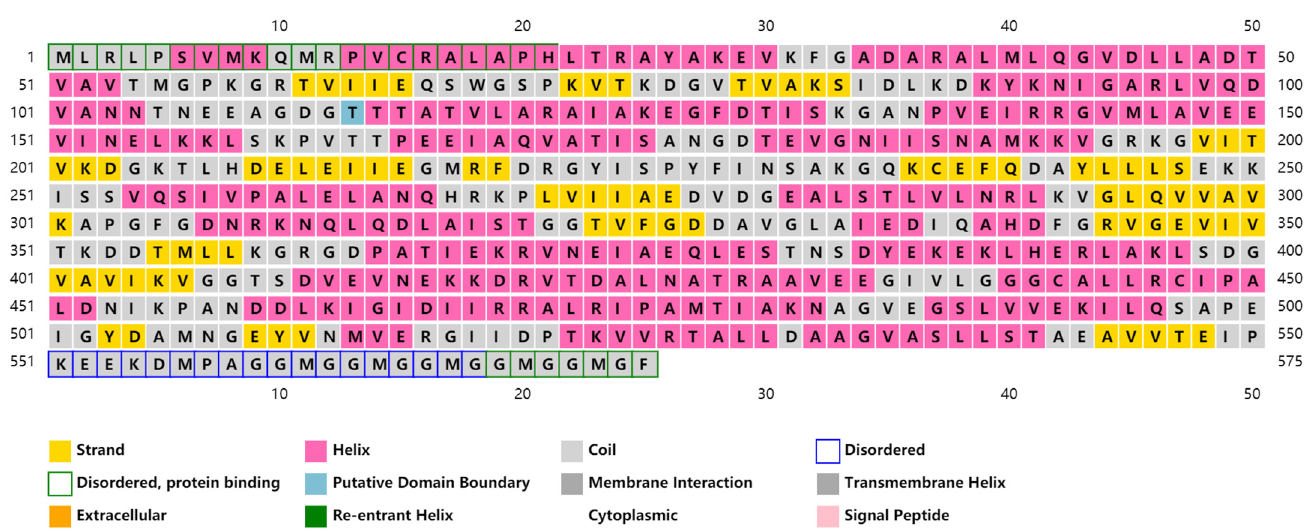
Figure 2. The secondary structure composition prediction of the Sp HSP60 protein.